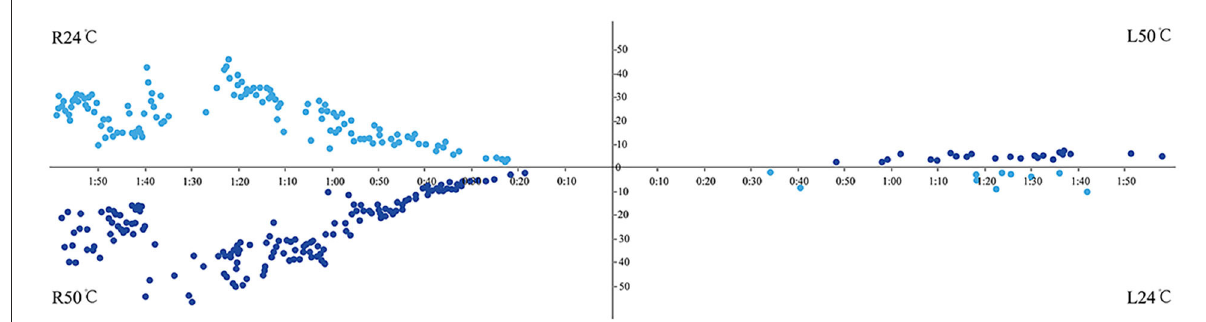
FIGURE1 Abnormal caloric test showed attenuation on the left side.